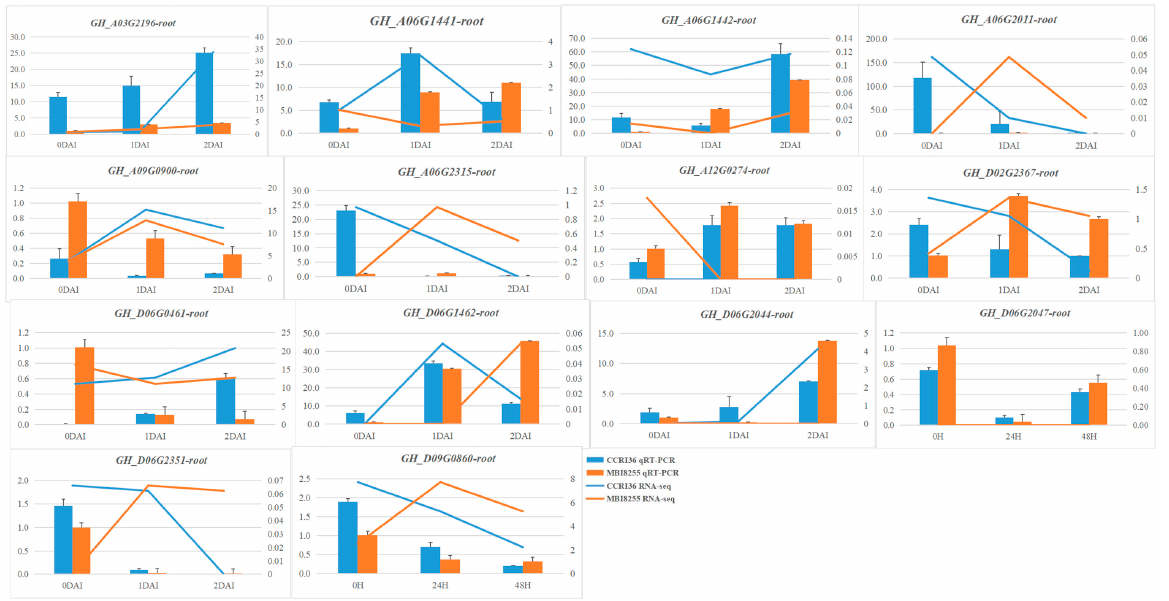
Figure 7. qRT-PCR verification of GhPPO genes in CCRI36 and MBI8255 roots infected by V991 for 0, 1, and 2